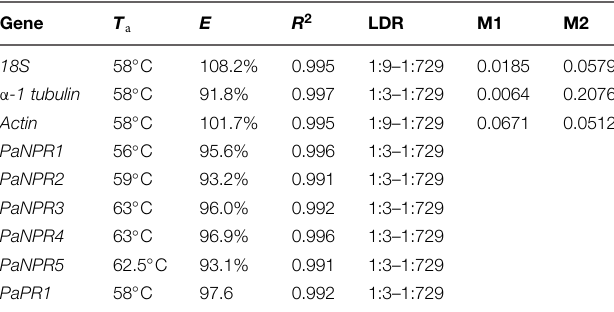
TABLE 3 | Reverse transcription quantitative PCR